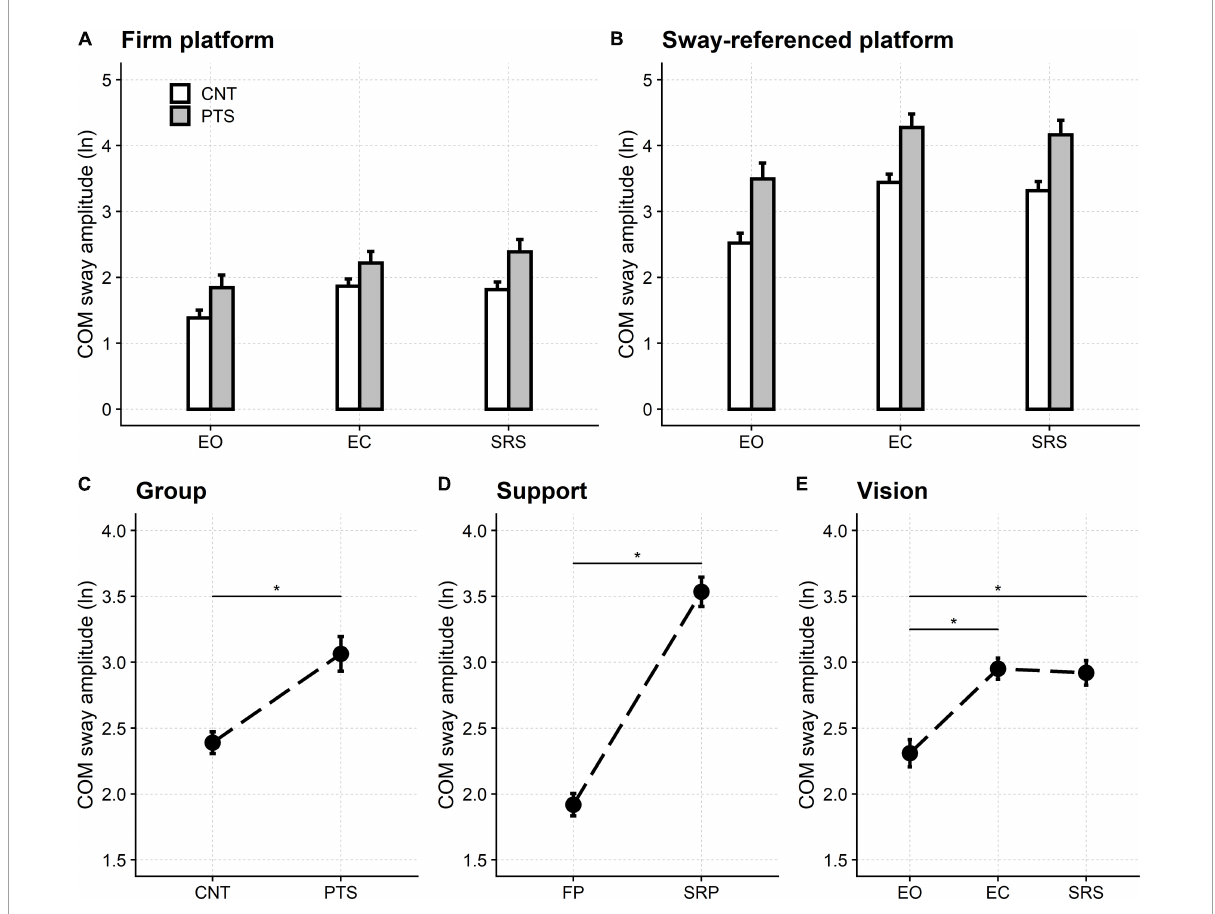
FIGURE2 Sensory organization test. Upper row: natural logarithm (ln) of the normalized amplitude of the sway of the centre of mass (COM) when standing on the firm (A) and the sway-referenced platforms (B) . Lower row: main effects of the regression model. The ln of the normalized COM sway amplitude is shown for the two groups of participants [ (C) Group], the two support conditions [ (D) Support], and the three visual conditions [ (E) Vision]. Even if significant, the model’s interactions did not alter this pattern of significance (see main text and